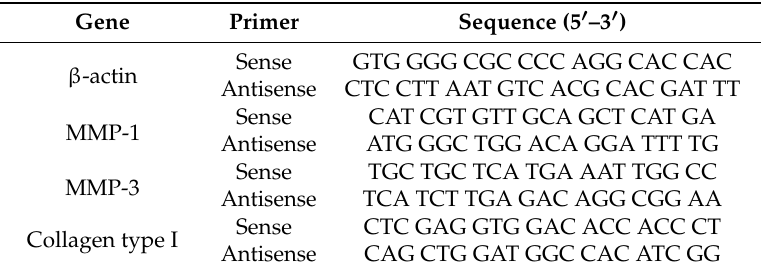
Table 1. List of primers for real-time RT-PCR. Gene Primer Sequence (5 (cid:48) –3 (cid:48)